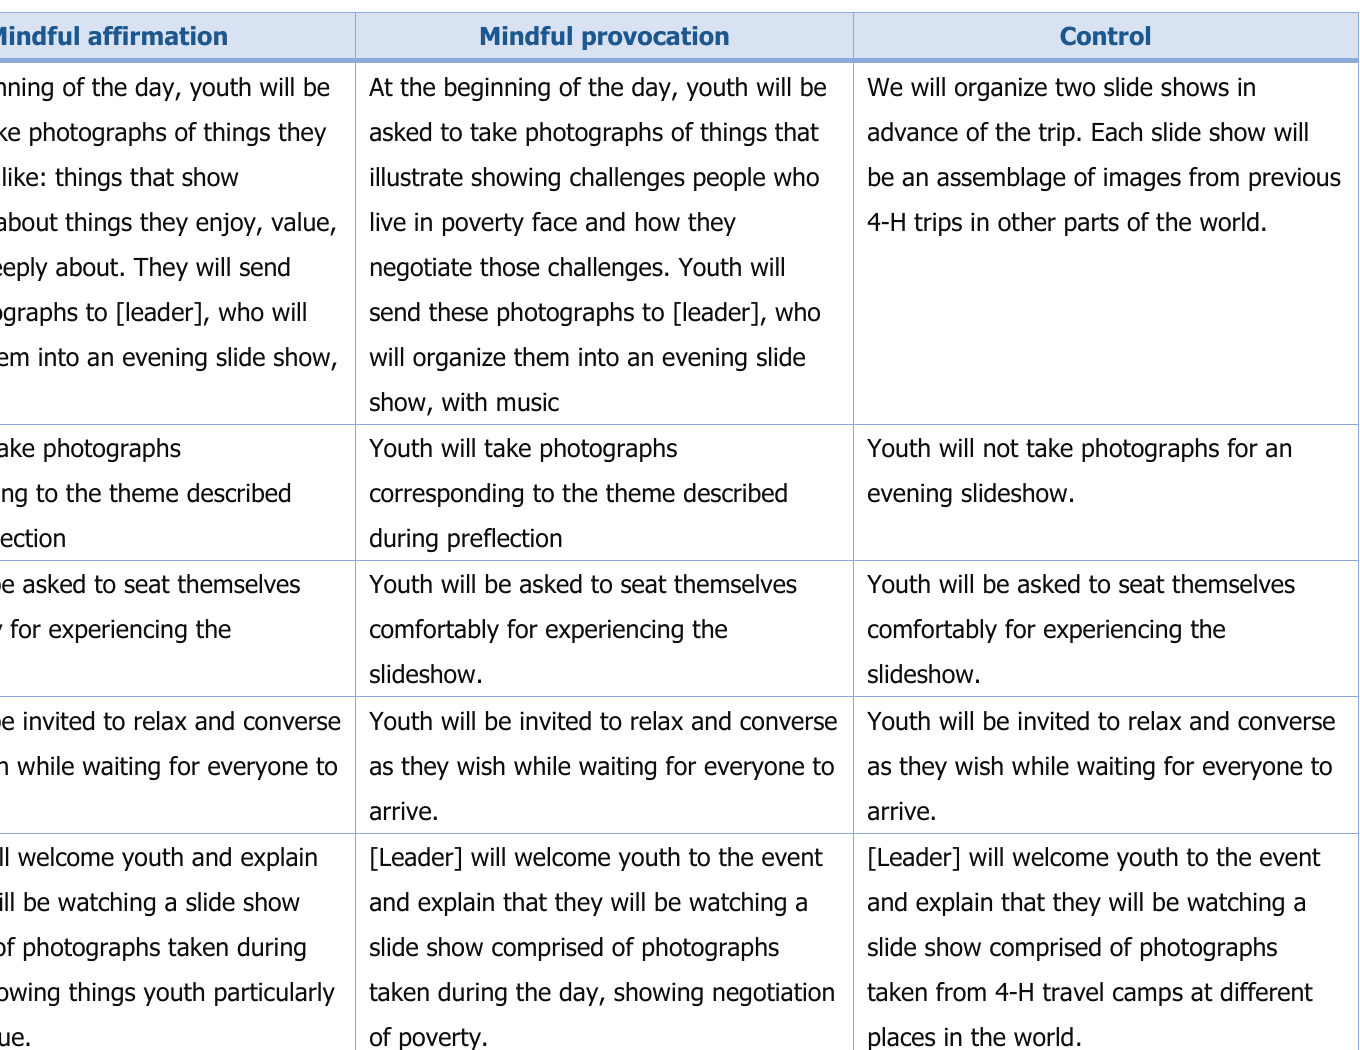
Table 1. YPPAR Experience Journey Plan (Protocol)